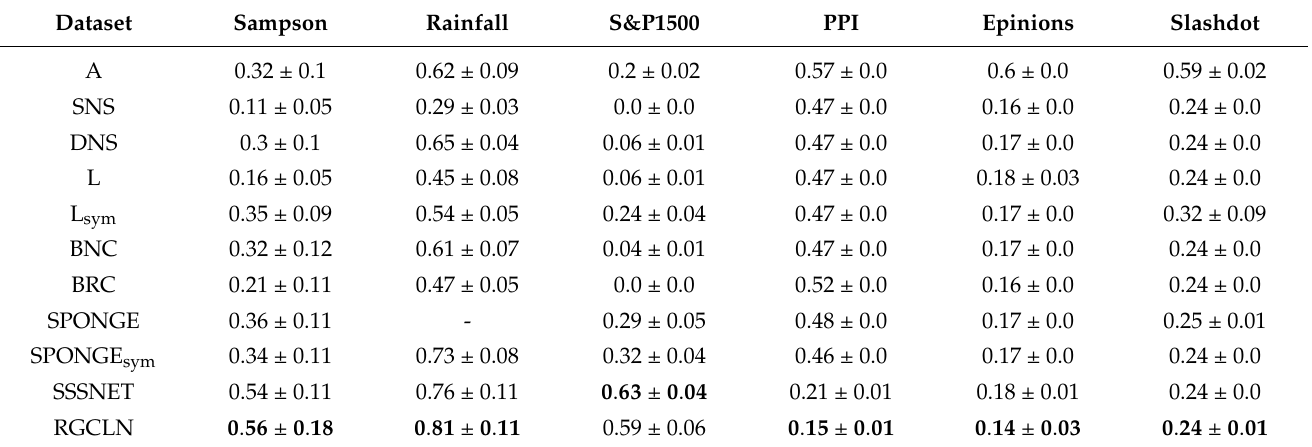
Table 2. Clustering performance on the real dataset; best outcomes are in bold. The first three columns are evaluated using ARI, where higher scores represent better classification results, and the rest of the dataset is evaluated by the unhappy ratio (%), where lower is